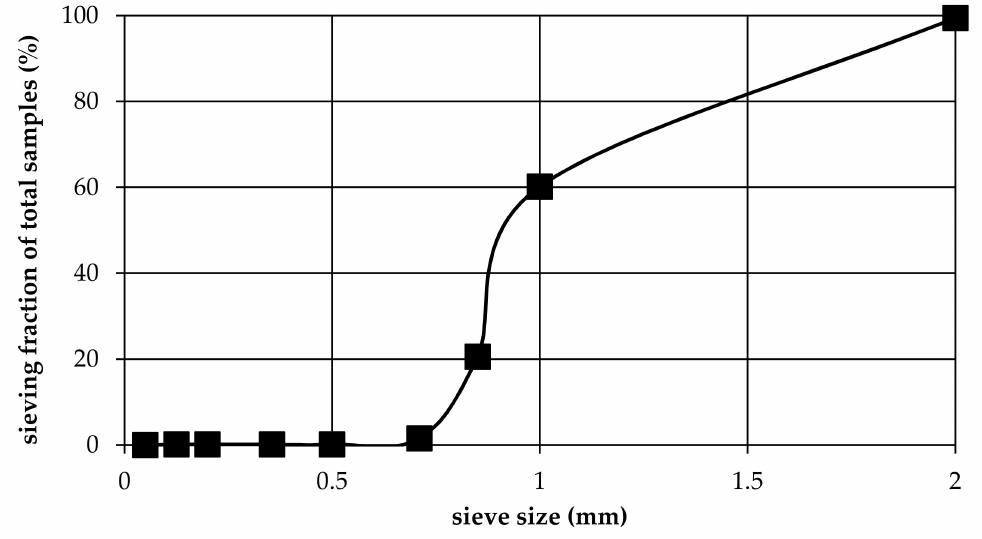
Figure 2. Sieving